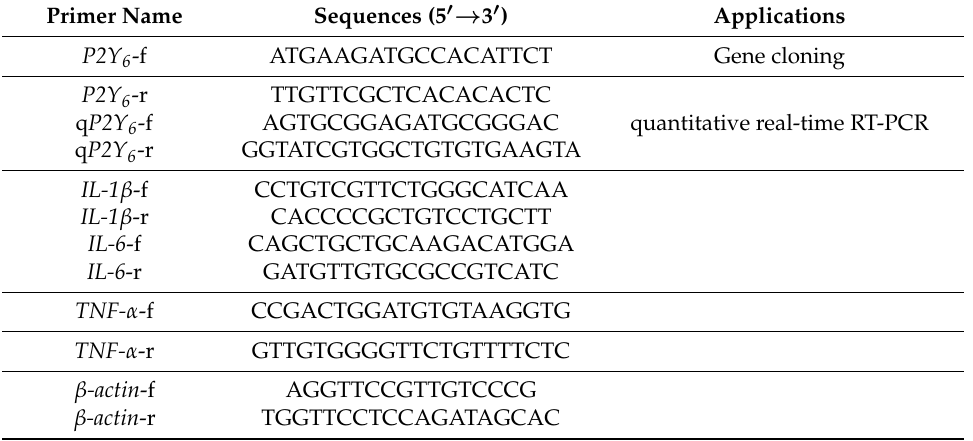
Table 1. The sequences of primers used in this